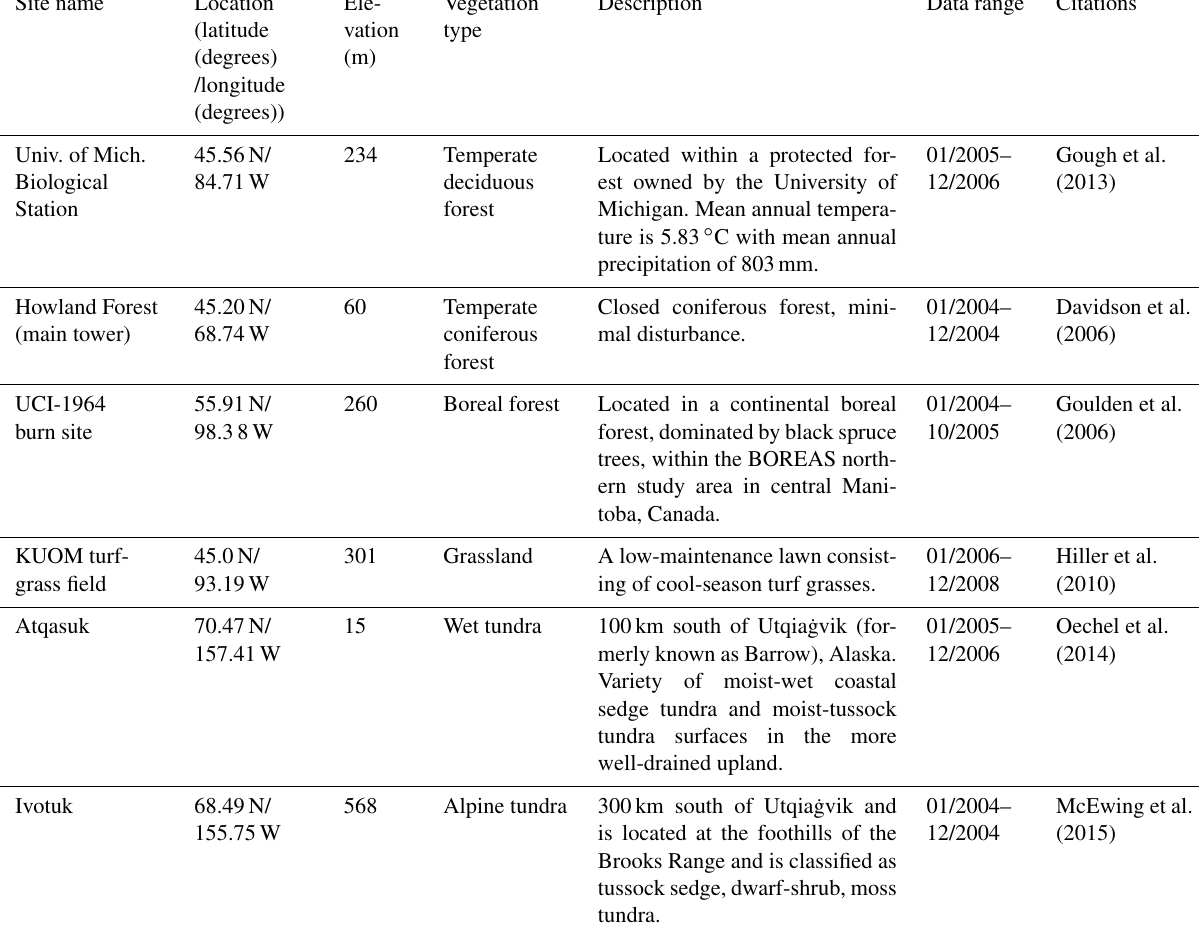
Table 2. Site description and measured NEP data used to calibrate